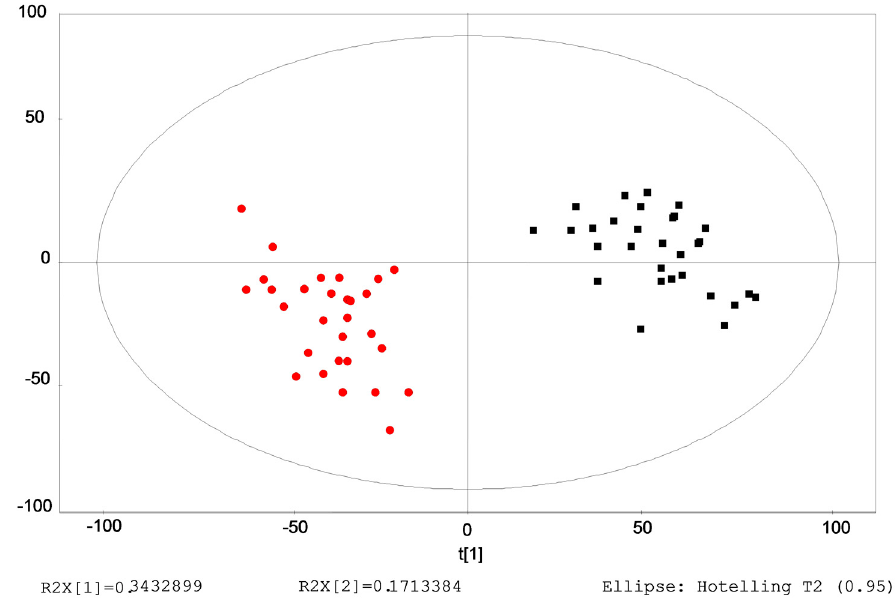
Figure 1. Multiple pattern recognition of metabolites in the control and ILAs groups. PLS-DA score plot ( n = 59): Control group ( ■ ); and ILAs group ( ● ).